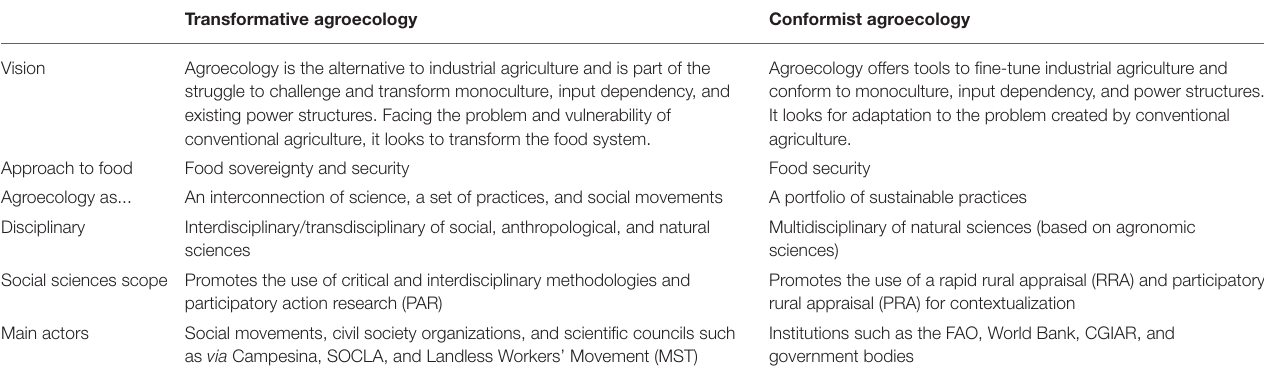
TABLE 1 | The dichotomy of agroecology worldviews (based on and adapted from Levidow et al., 2014; Giraldo and Rosset,